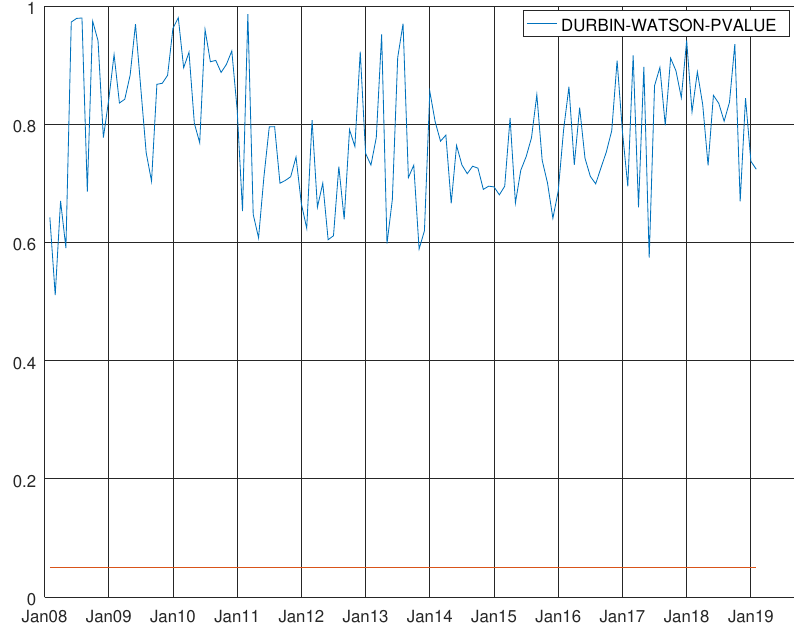
Figure 19. Graph showing the p -values of the Durbin–Watson test for the enhanced model for capital goods. The null hypothesis states that residuals are not